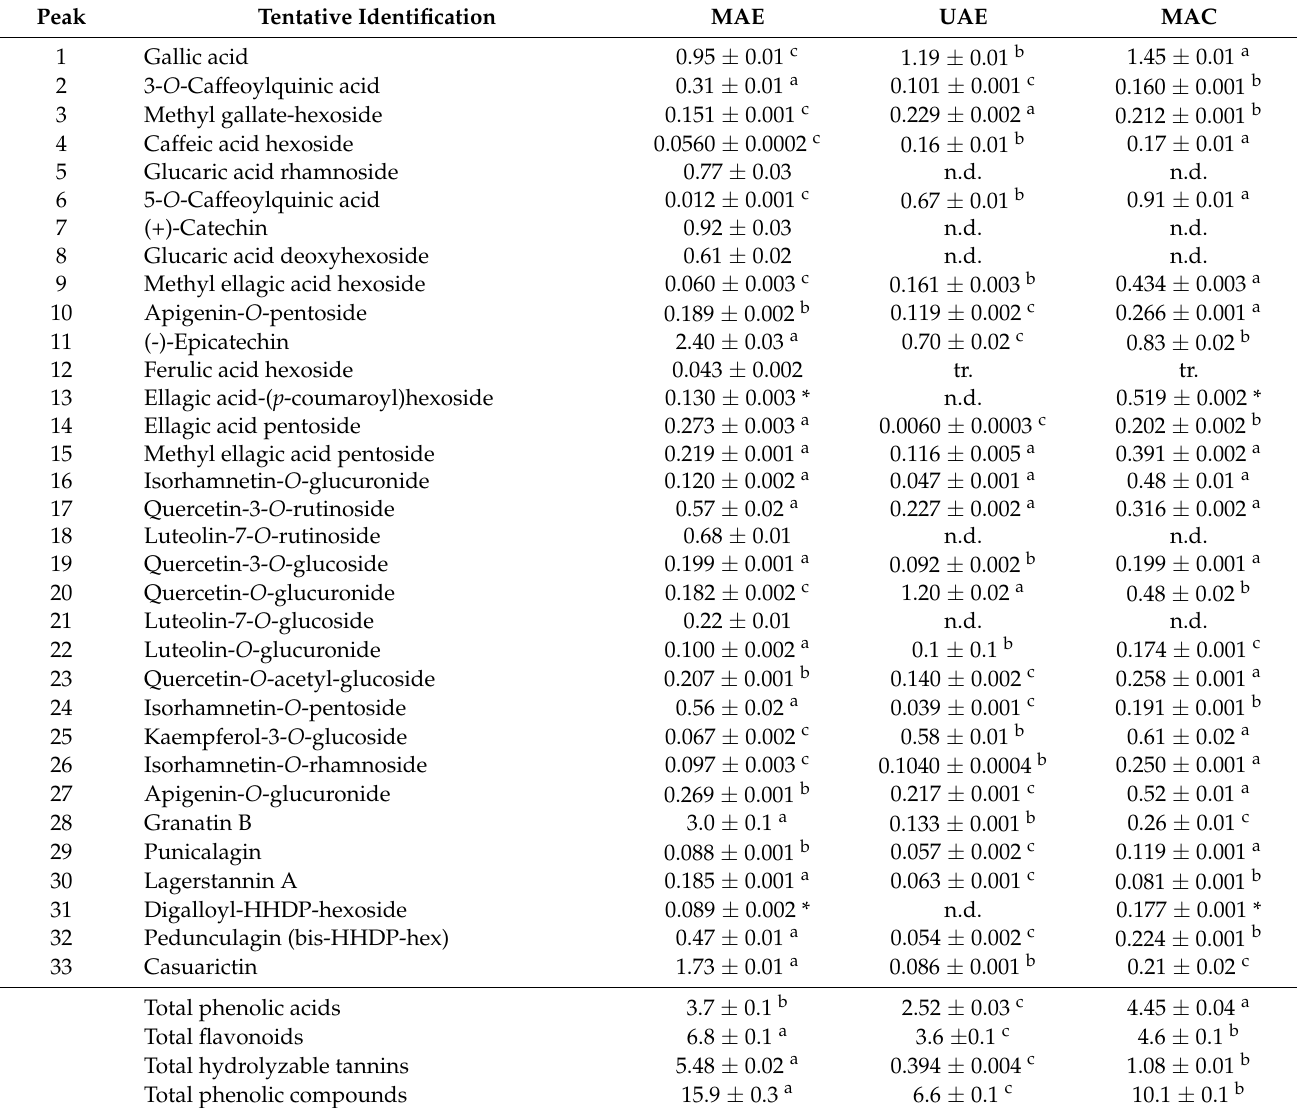
Table 2. Quantification (mg/g) of the phenolic compounds in the pomegranate leaf